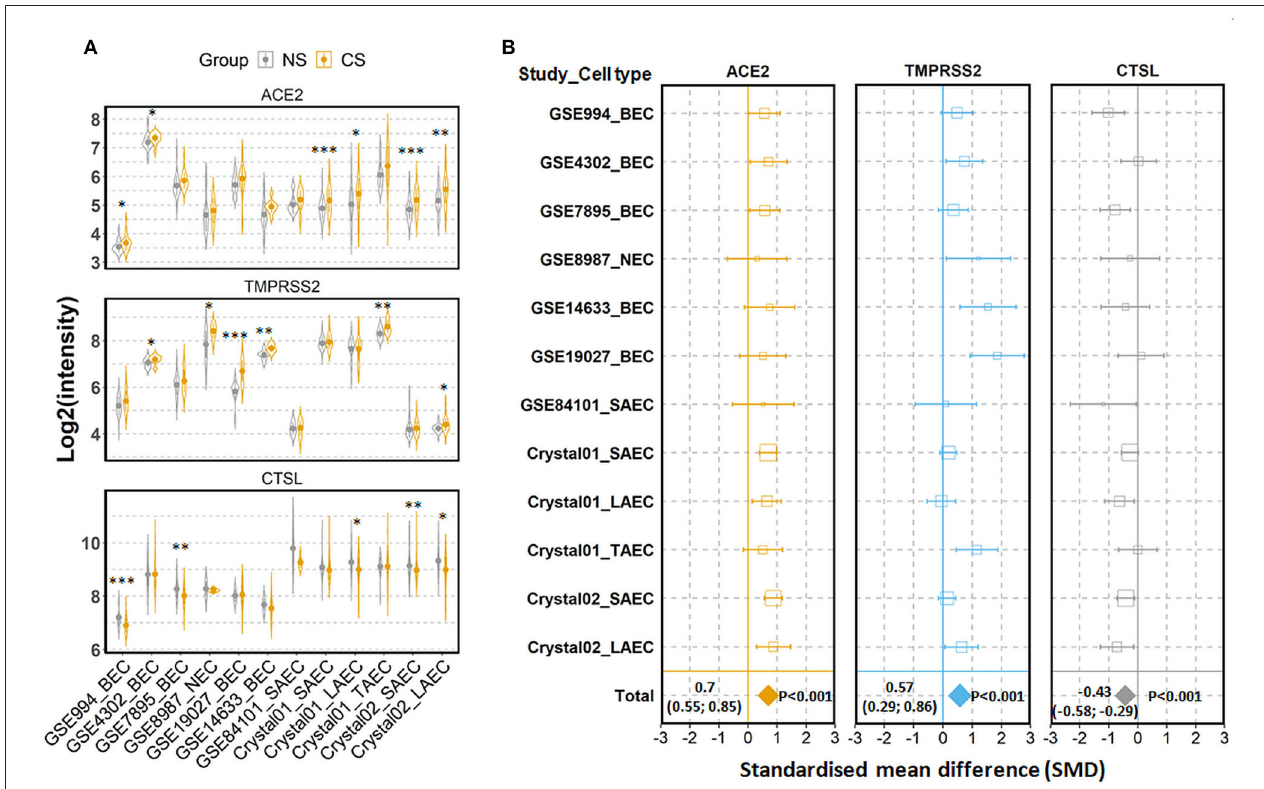
FIGURE 2 | Expression of ACE2, TMPRSS2, and cathepsin L (CTSL) in airway epithelial cells of healthy current smokers (CS) and never smokers (NS). (A) Violin plot of expression levels of ACE2, TMPRSS2, and CTSL in 12 datasets which contain current smokers and never smoker. Mean and standard deviation (SD) of each group are presented as dot and line, respectively. Statistical difference was calculated by Student’s t -test. * p < 0.05, ** p < 0.01, *** p < 0.001. (B) Forest plot of 12 datasets examining expression of ACE2, TMPRSS2, and CTSL in current smokers and never smokers. The x-axis indicates the standardized mean difference (SMD), while the y-axis shows GEO datasets and cell types. Each square in the plots represents the SMD in corresponding datasets and the 95% confidence interval (CI) is shown by the error bar. The size of each square represents the weight of the individual dataset in the meta-analysis. The diamonds in the bottom represent the SMD of the meta-analysis. The SMD, 95% CI and P -values of meta-analysis are depicted. BEC, bronchial epithelial cell; NEC, nasal epithelial cell; SAEC, small airway epithelial cell; LAEC, large airway epithelial cell; TAEC, trachea airway epithelial cell.